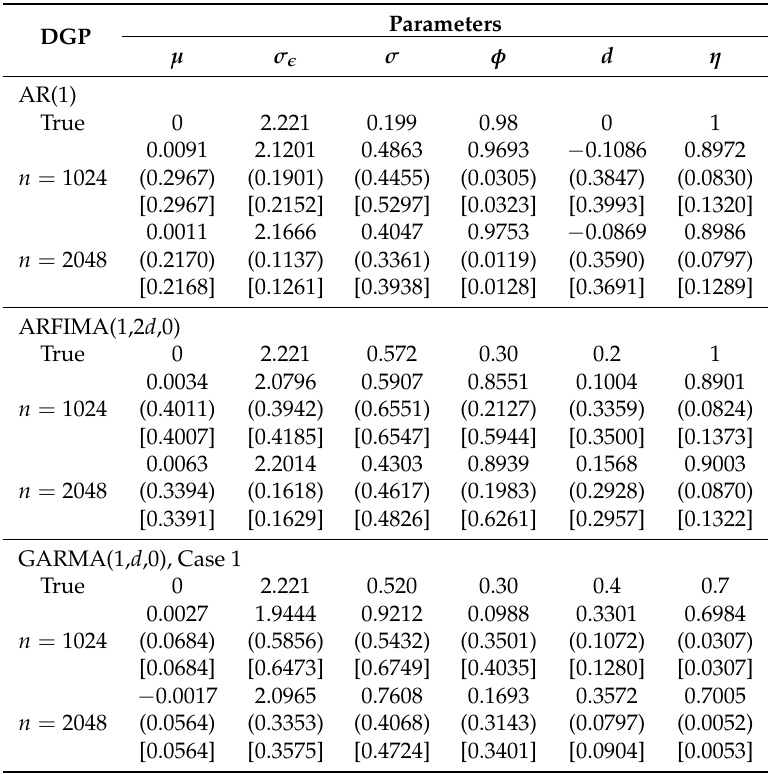
Table 1. Finite Sample Performance of the SL Estimator of